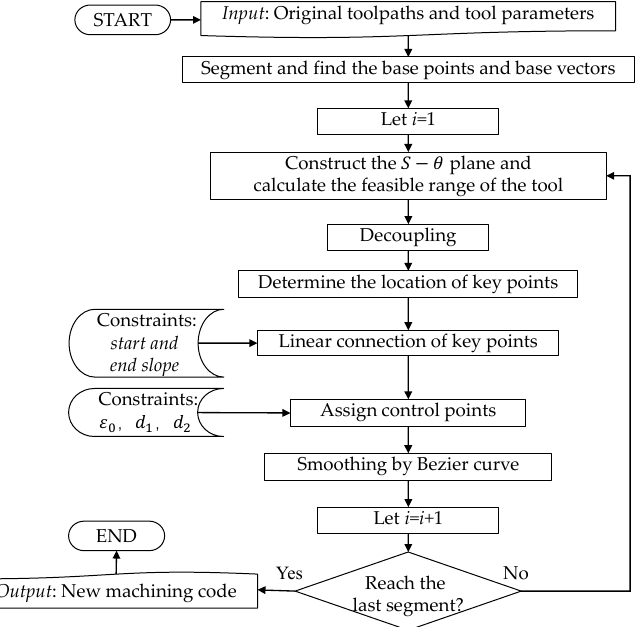
Figure 12. The overall flow chart of tool orientation scheduling.